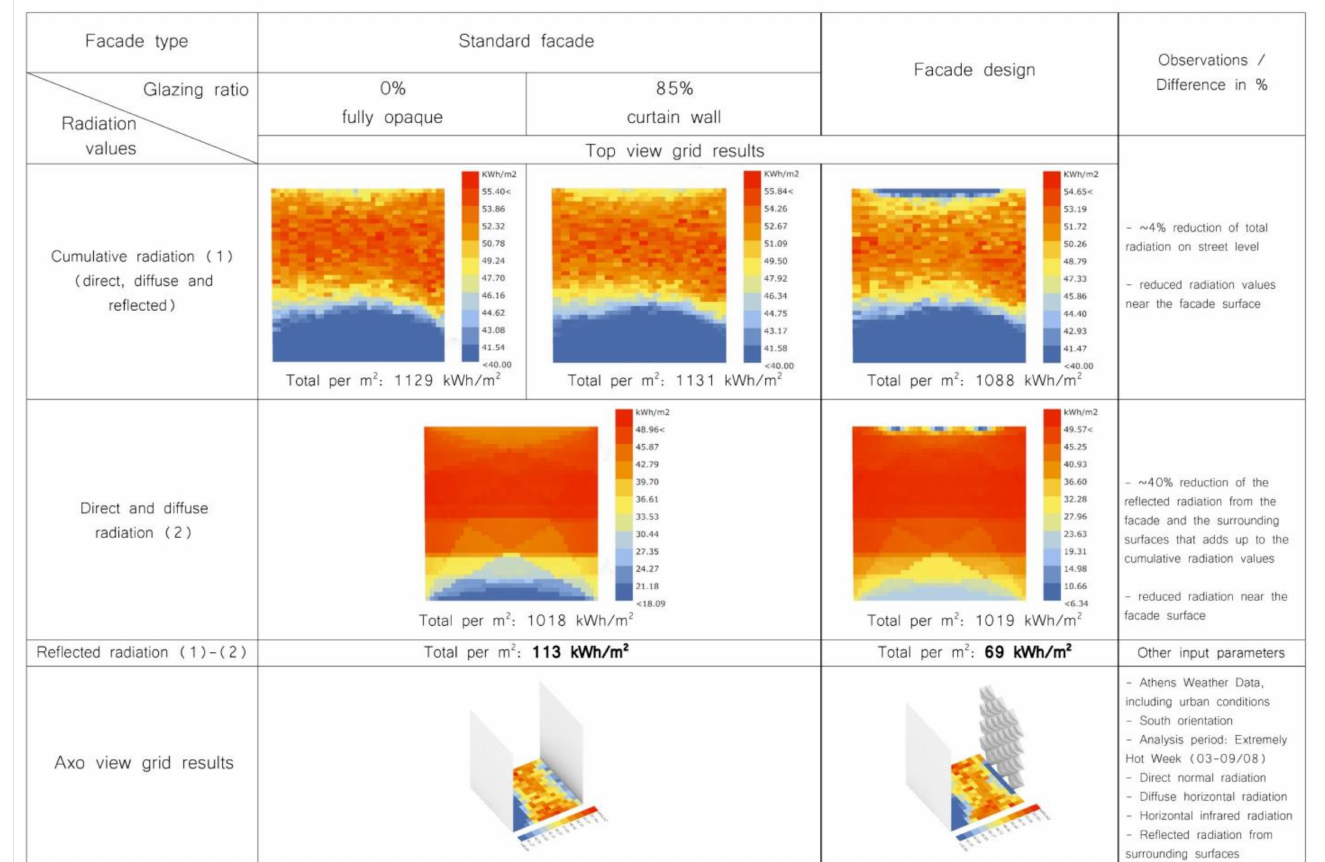
Figure 18. Analysis and partial values of the total cumulative radiation on street level in an Athens urban canyon (cumulative radiation: direct, diffuse, and reflected radiation from all the surrounding